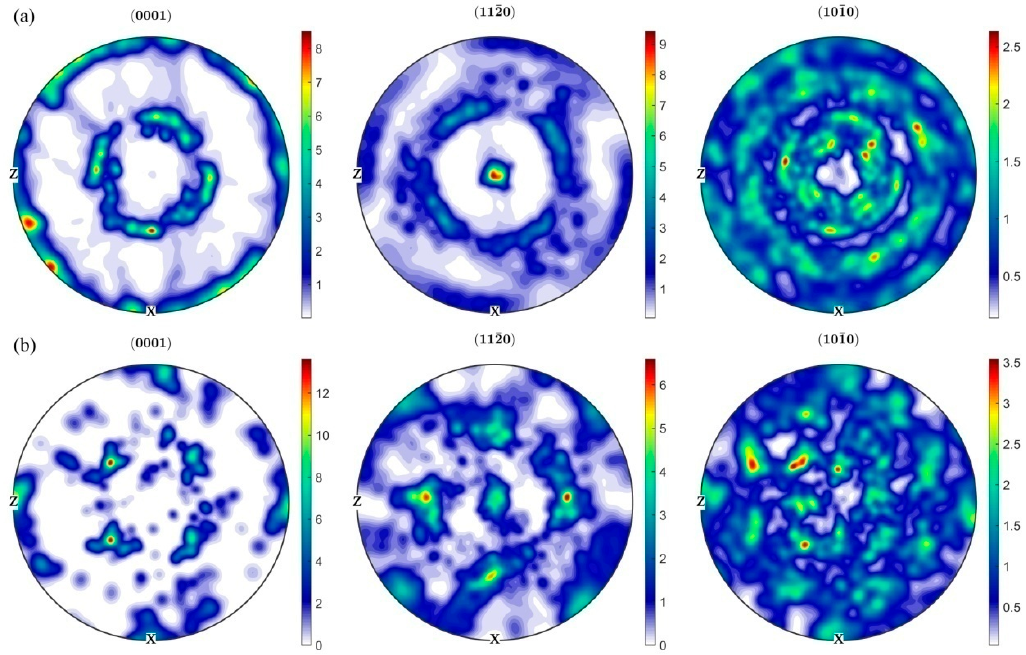
Figure 9. Simulation resulted for the transformation texture based on the parent β texture shown in Figure 2, under the assumption that all the twelve α variants occur with the same probability. ( a ) 2 s − 1 , ( b ) 0.02 s − 1 .